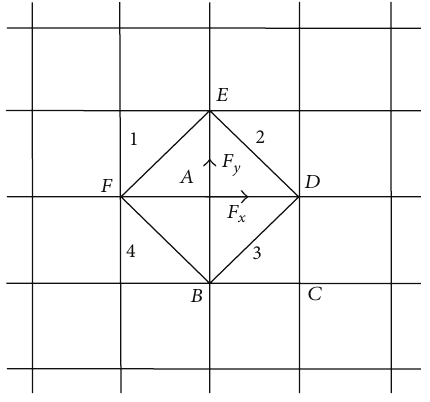
Figure 1: Mesh for rectangular element